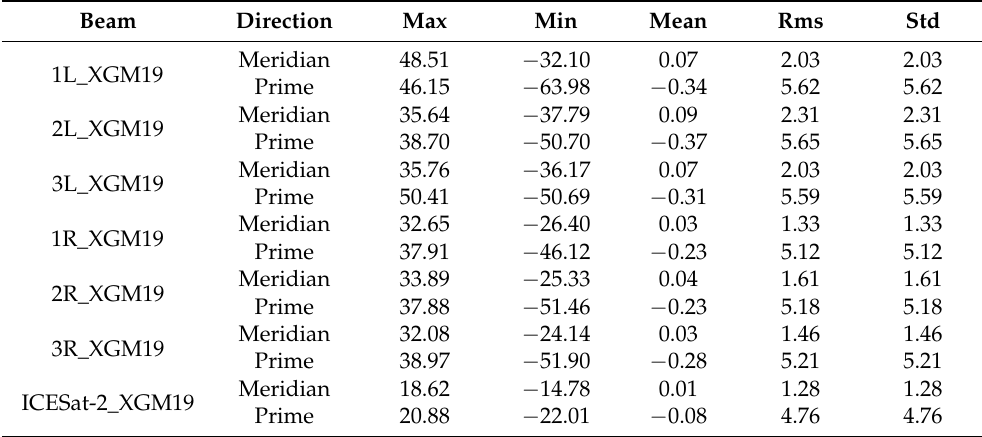
Table 10. Statistics of differences between gridded DOVs calculated by the along-beam DOVs and the XGM2019e_2159-DOV model (Unit: